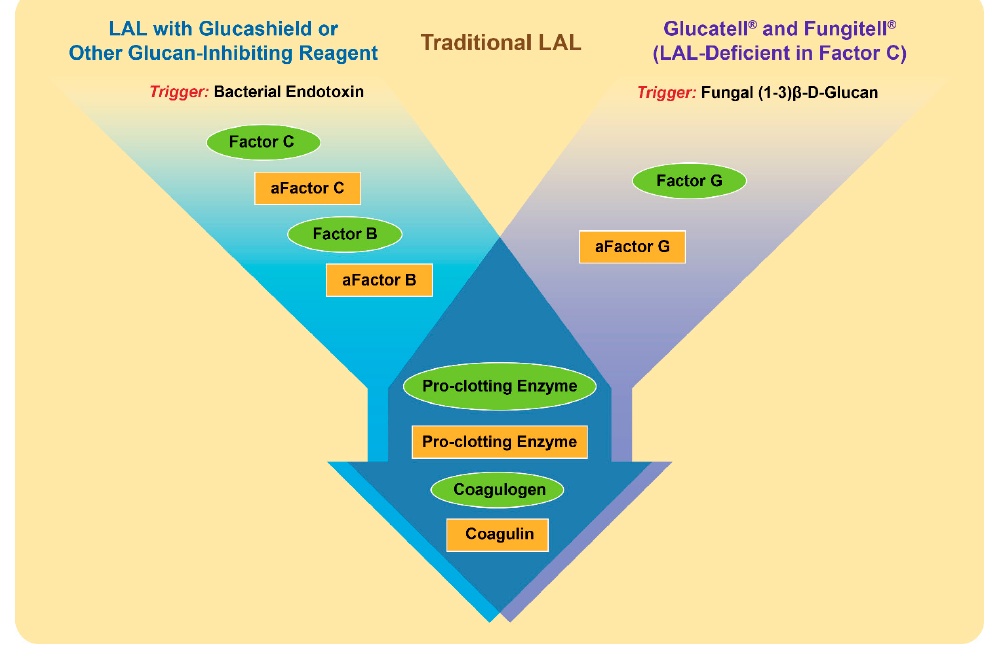
Figure 3. Proteins and triggering factors of the Limulus amoebocyte lysate (LAL) Assay. Proteins in the amoebocyte lysate of the horseshoe crab Limulus Polyphemus are zymogens organized in a sequential enzymatic cascade. These proteins are shown in the figure as green ovals. After the activation by either a triggering factor or preceding protein, the active form of a protein forms and is shown as a yellow rectangle; “a” at the beginning of the protein name refers to its activated state. The LAL assay